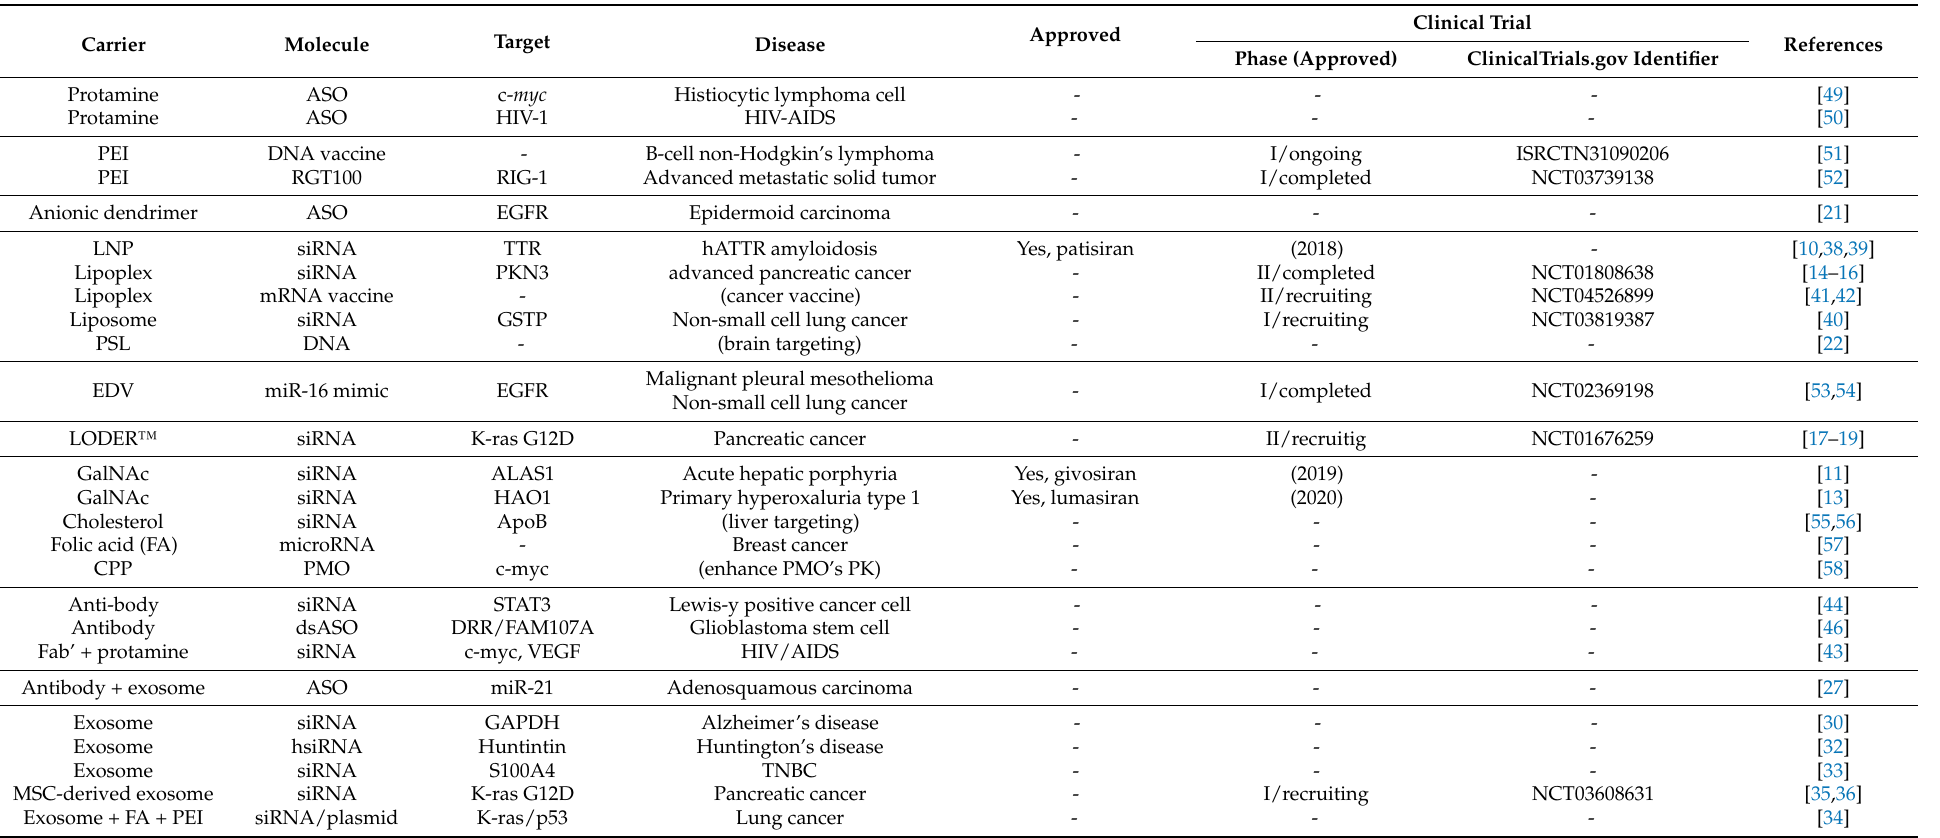
Table 1. Drug delivery systems (DDS) for nucleic acid drugs, including those in clinical